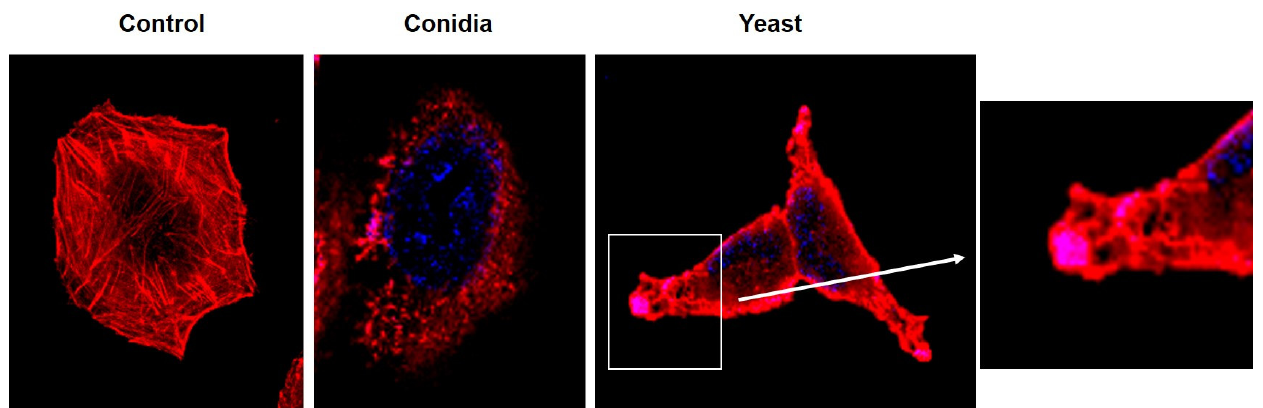
Figure 3. Formation of membrane protuberances and loss of stress fibers in keratinocytes infected with conidia and yeast cells of Sporothrix schenckii . Infection with conidia and yeast cells of Sporothrix schenckii at 6 h post-infection at a 1:1 MOI. The actin filaments were stained with rhodamine phalloidin (red), and the cell nuclei with DAPI (blue). Digitally amplified